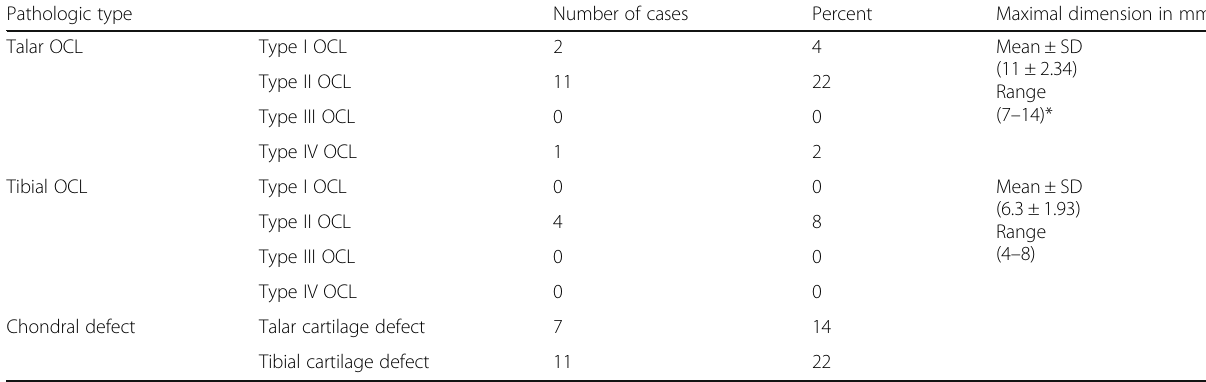
Table 3 Chondral and OCL lesions and their dimension Pathologic type